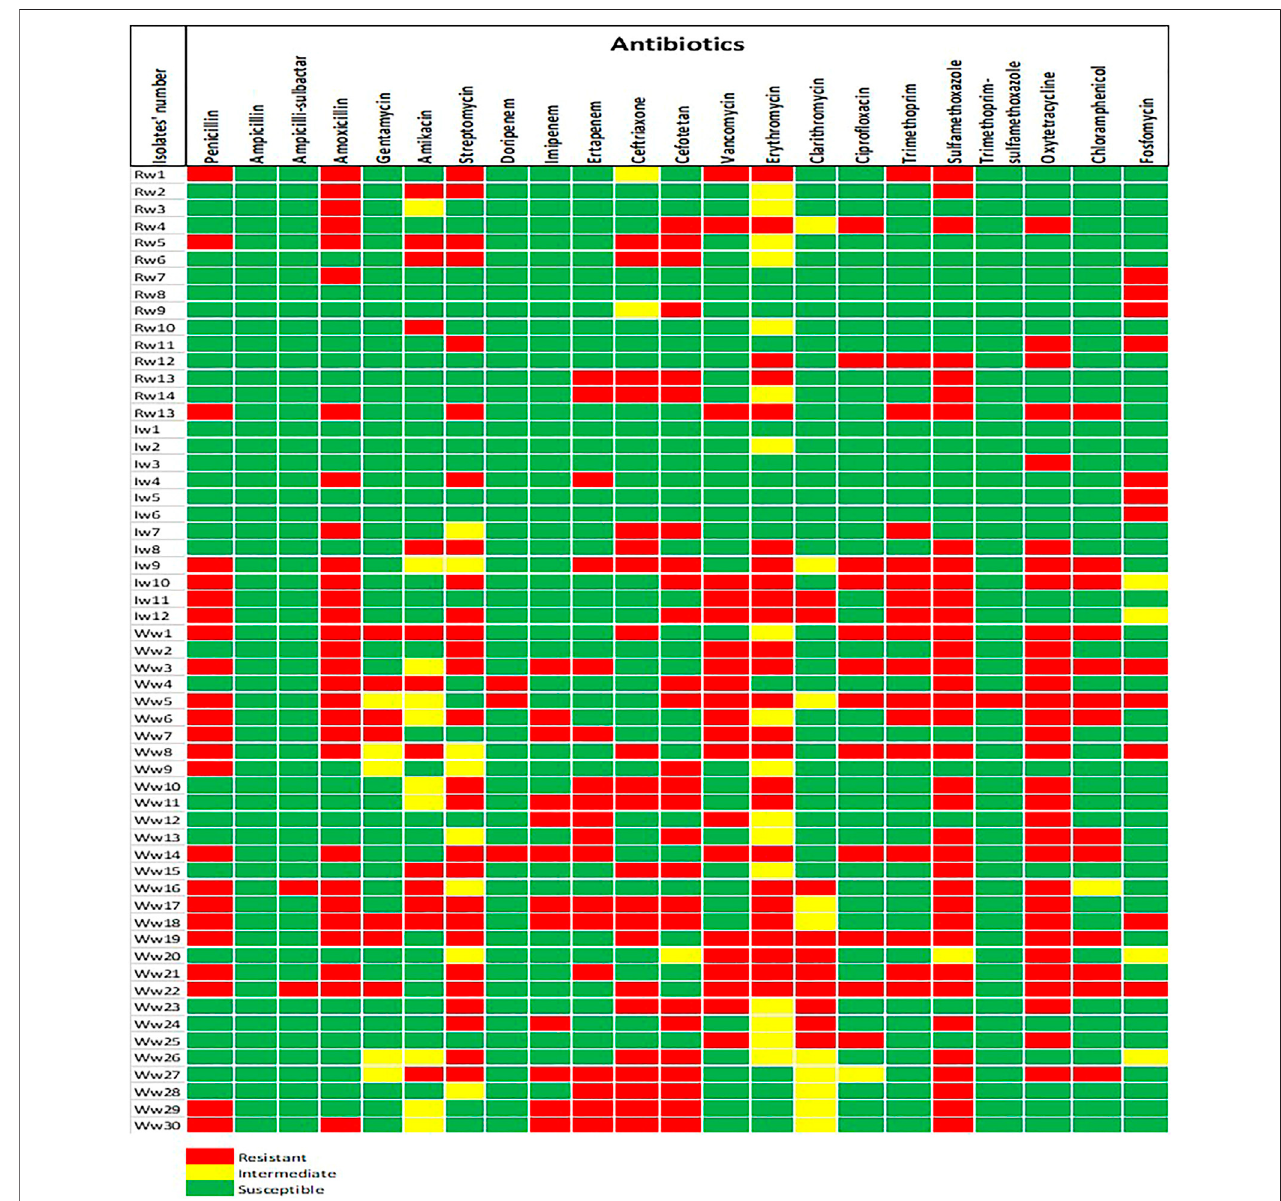
FIGURE 1 | The phenotypic antibiotic resistance pro fi les of Listeria monocytogenes isolates recovered from environmental waters. The color codes indicated resistant, intermediate, and susceptible phenotypes to 22 antibiotics. The code (Rw) denotes isolates recovered from river water, (Iw) for irrigation water, and (Ww) for